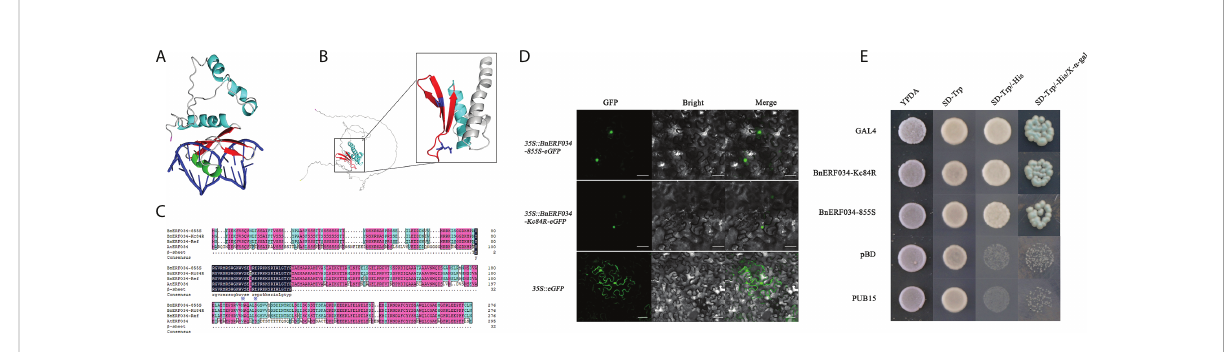
FIGURE 8 Bioinformatics analysis and related functional analysis of ERF034. (A) Conserved structural domain elements of ERF transcription factors. (B) Structure prediction of At ERF034 and characterization of its ERF structural domain. (C) Comparison of the ERF034 and b -sheet sequences from 855S, Kc84R and A . thaliana . (D) Subcellular localization of Bn ERF034-eGFP, scale bars represent 50 m m. (E) Transcriptional activation activity veri fi cation of Bn